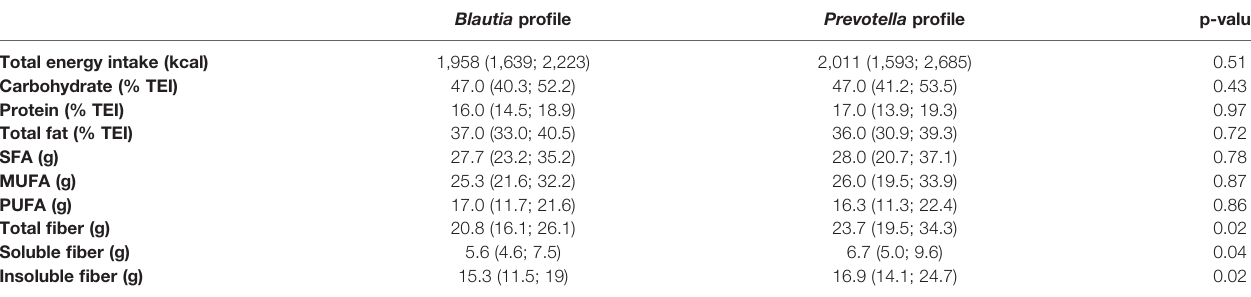
TABLE 2 | Medians (interquartile range) of total energy intake (TEI) and dietary data of the 114 participants according to pro fi